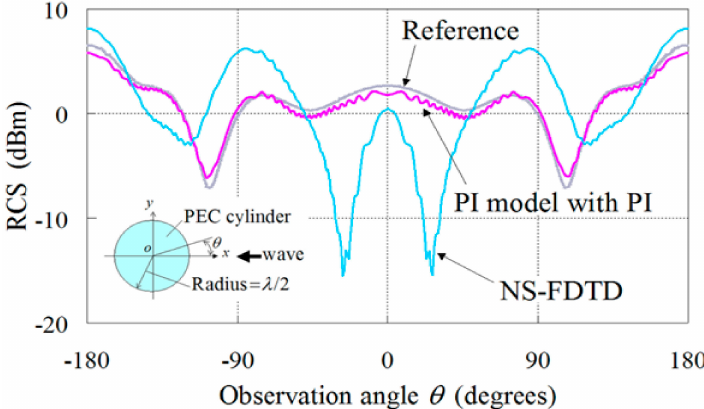
Figure 5. RCS results obtained via the FDTD, the NS-FDTD, and the proposed 2D CP model for the computational configuration of Figure 4. The incident angle of the TE plane wave is θ inc = 0 ◦ . Moreover, the FDTD results are obtained with ∆ = λ /120 and ∆ t = T /170 (via the usual stair- case discretization scheme), while the NS-FDTD results (without the CP model) are extracted with ∆ = λ